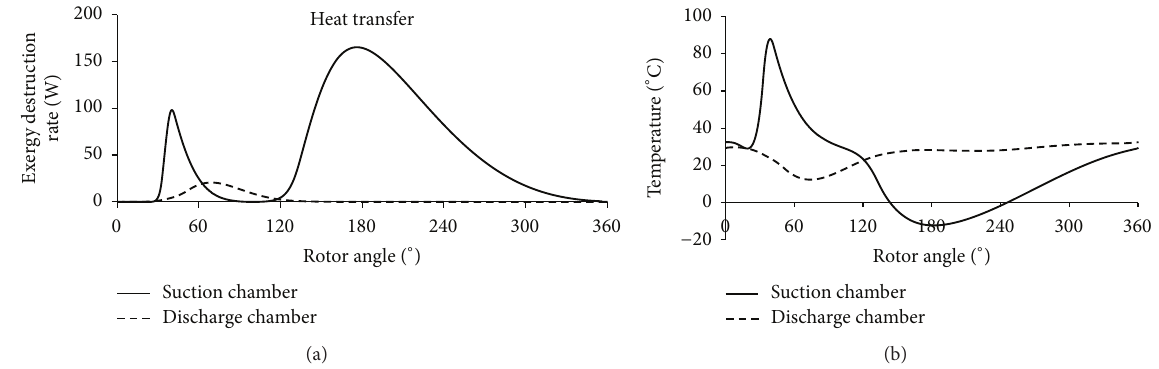
Figure 3: (a) Exergy destruction rate due to heat transfer and (b) temperature variations of the fluid.